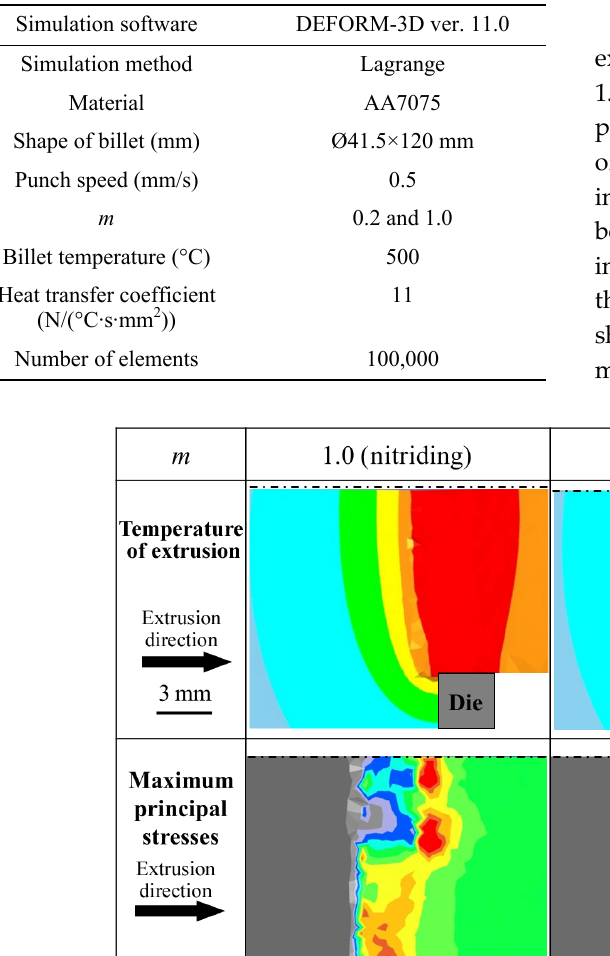
Table 5 Simulation conditions of hot extrusion test.